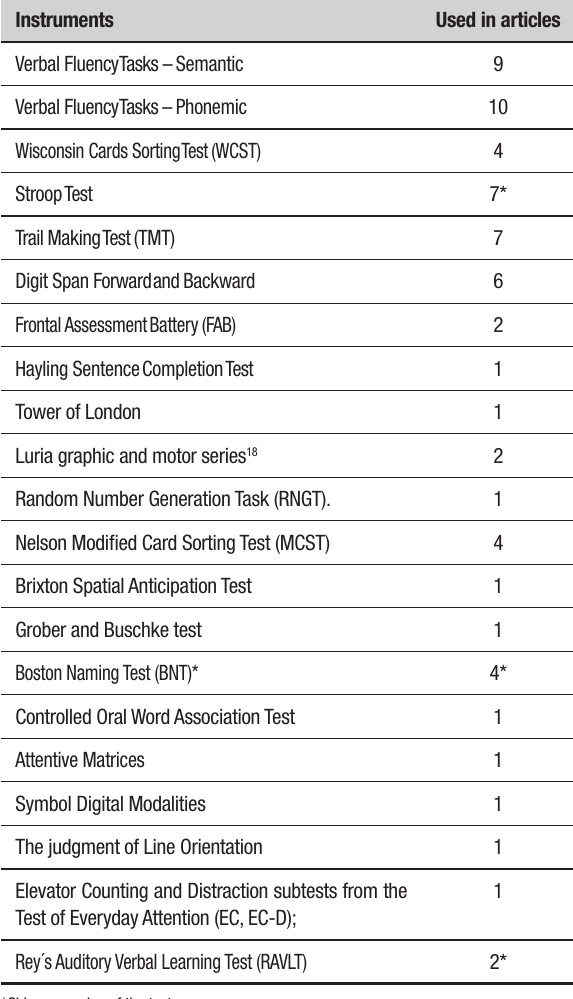
Table 2. List and frequency of instruments used.